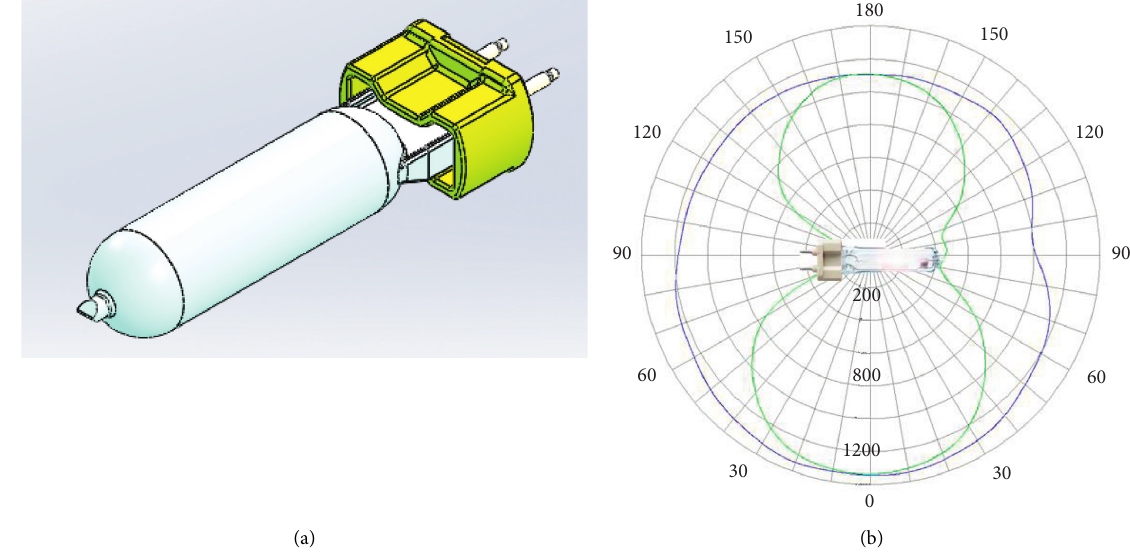
Figure 4: (a) Three-dimensional view of the 150W Philips MASTERColour bulb. (b) Illuminance distribution from the light source model